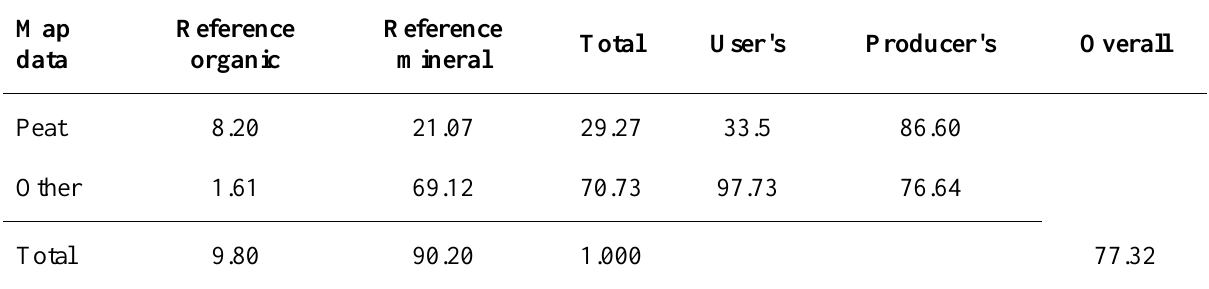
Table 2. Error matrix based on reference data expressed as estimated proportion of the target area, where rows represent map classes and columns represent reference data classes.